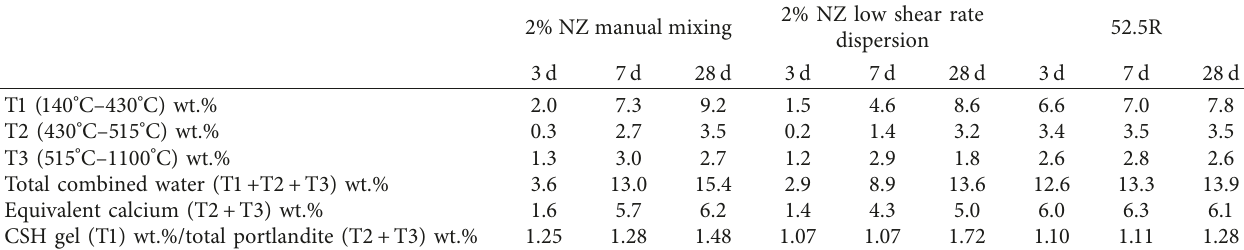
Table 1: Water losses associated with different phases in cement pastes with 2 wt.% of nanozinc